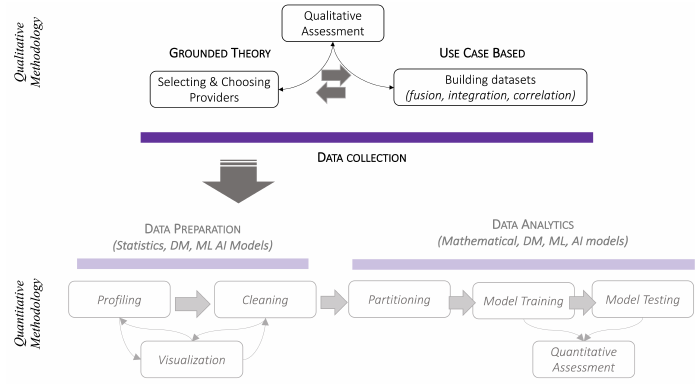
Figure 1. Qualitative methodology for identifying missing